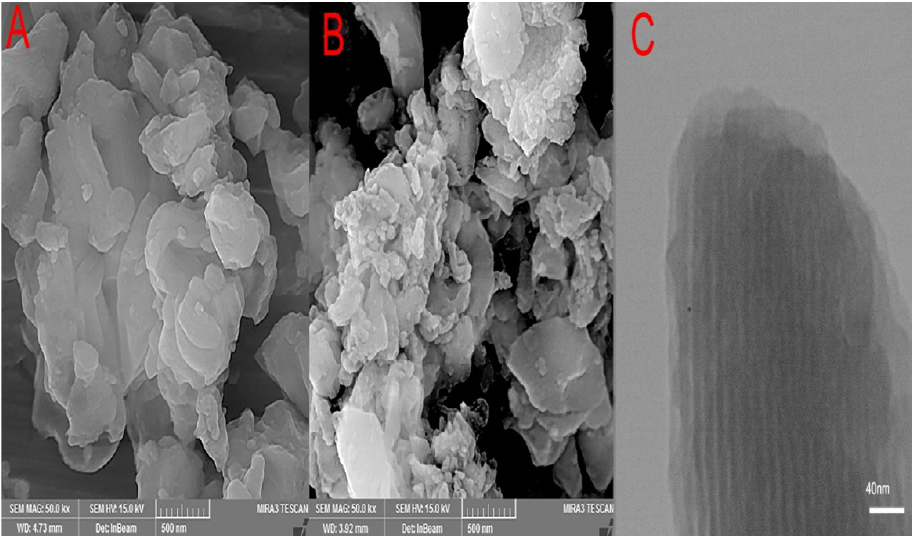
Fig. 4. SEM images of (A) SBA-15 and (B) Pd@modified SBA-15 (C) TEM image of Pd@modified SBA-15 Figure 4. SEM images of (A) SBA‐15 and (B) Pd@modified SBA‐15 (C) TEM image of Pd@modified SBA‐15